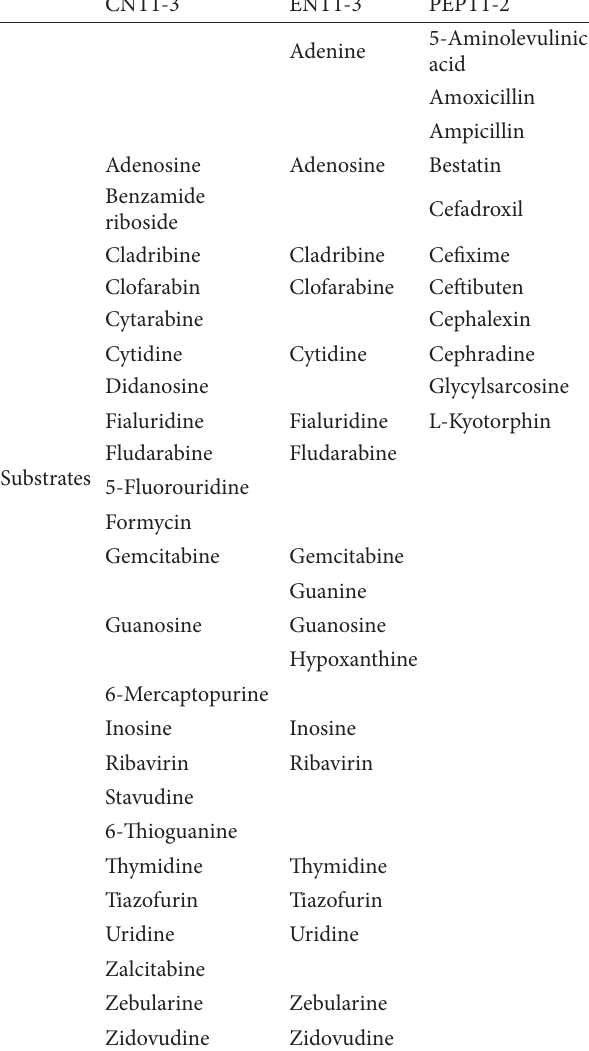
T 3: Identi�ed potential substrates of hepatic forms of CNTs, ENTs, and PEPTs with pharmacological